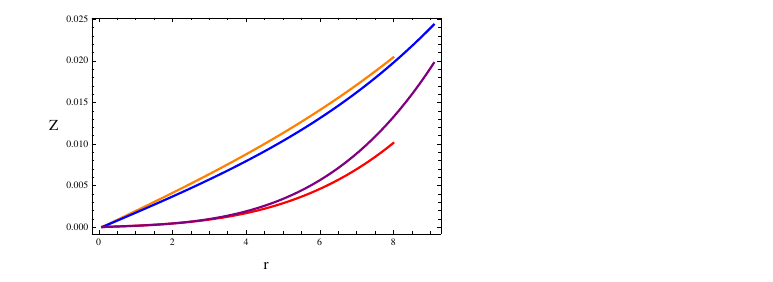
Figure 7. Plots of mass, compactness and redshift versus r corresponding to ψ = 0.1 (Orange), ψ = 0.9 (Red) (Her X-1) and ψ = 0.1 (Blue) and ψ = 0.9 (Purple) (4U 1820-30) for solution I.